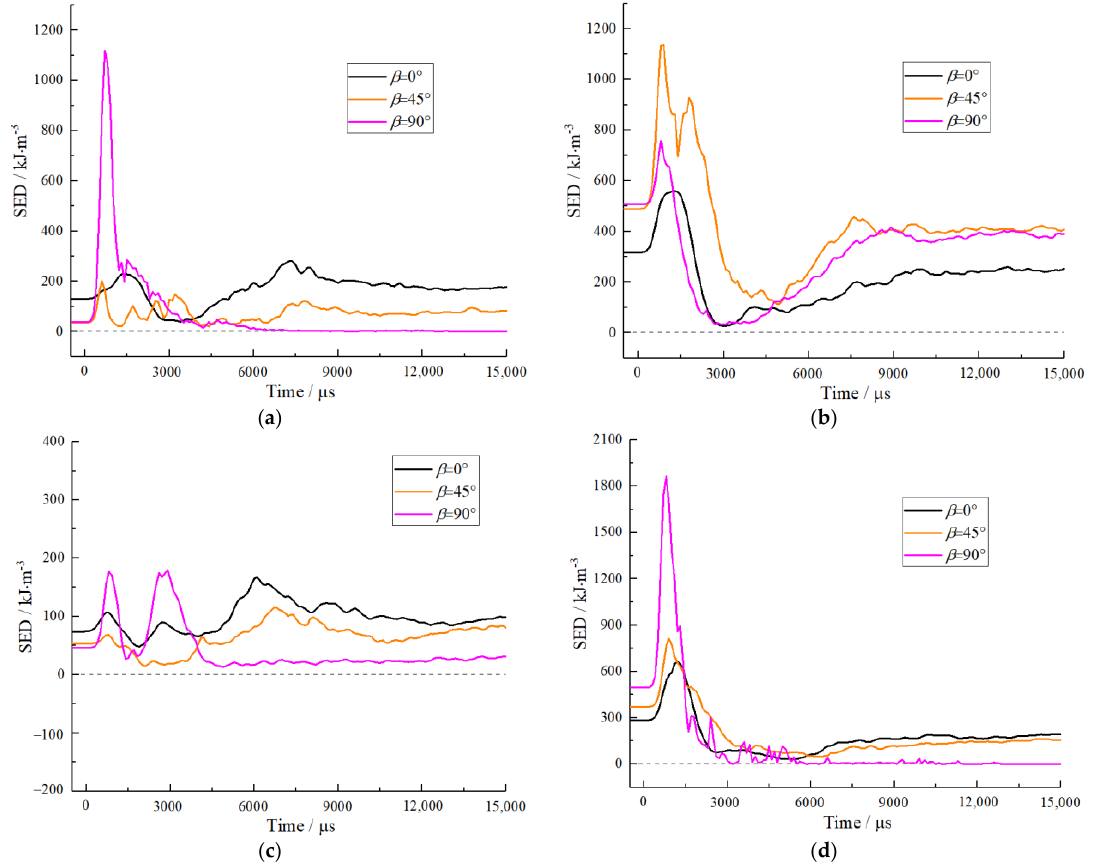
Figure 10. SED-time curve of typical zones under different tunnel dips: ( a ) B1; ( b ) B2; ( c ) B3; ( d ) B4.